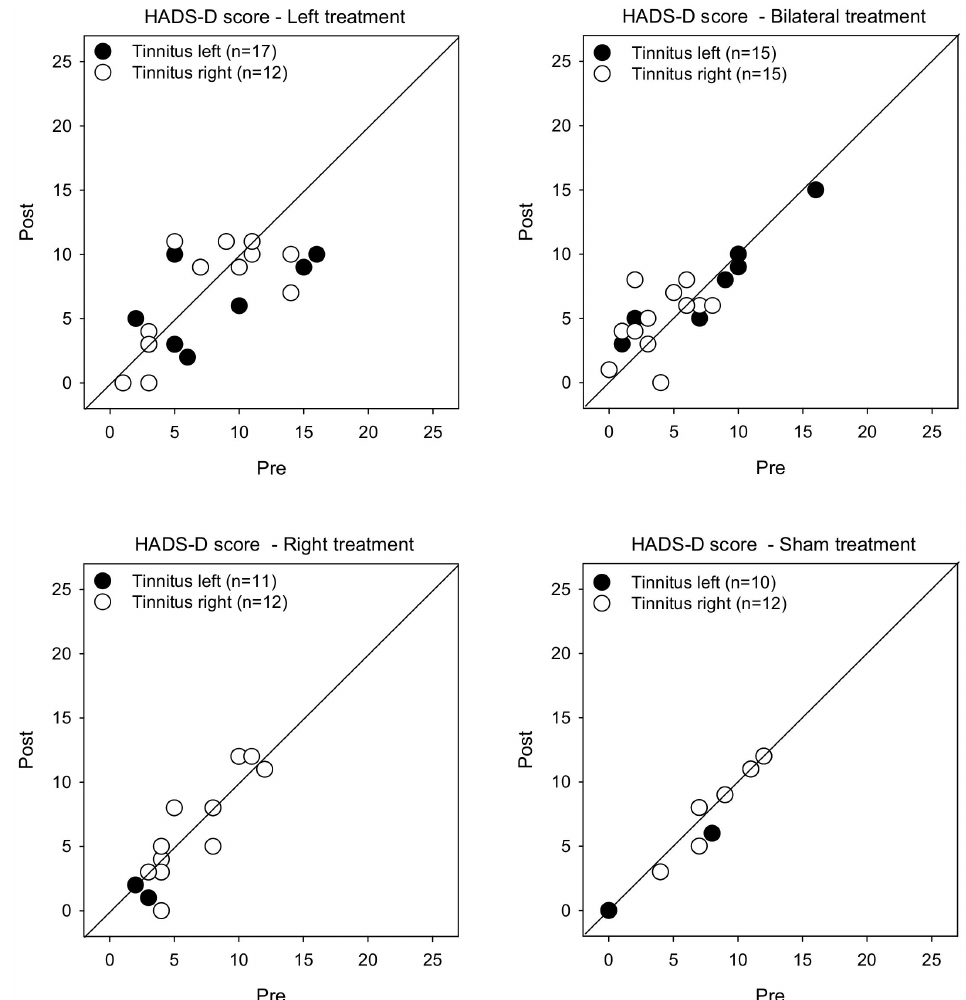
Figure 4. Post-treatment HADS-D scores as a function of pre-treatment scores for the Left, Right, Bilateral, and Sham treatment groups. The filled and open symbols show data for patients with left- or right-sided tinnitus, respectively. Values below the diagonal line indicate reduced depression after